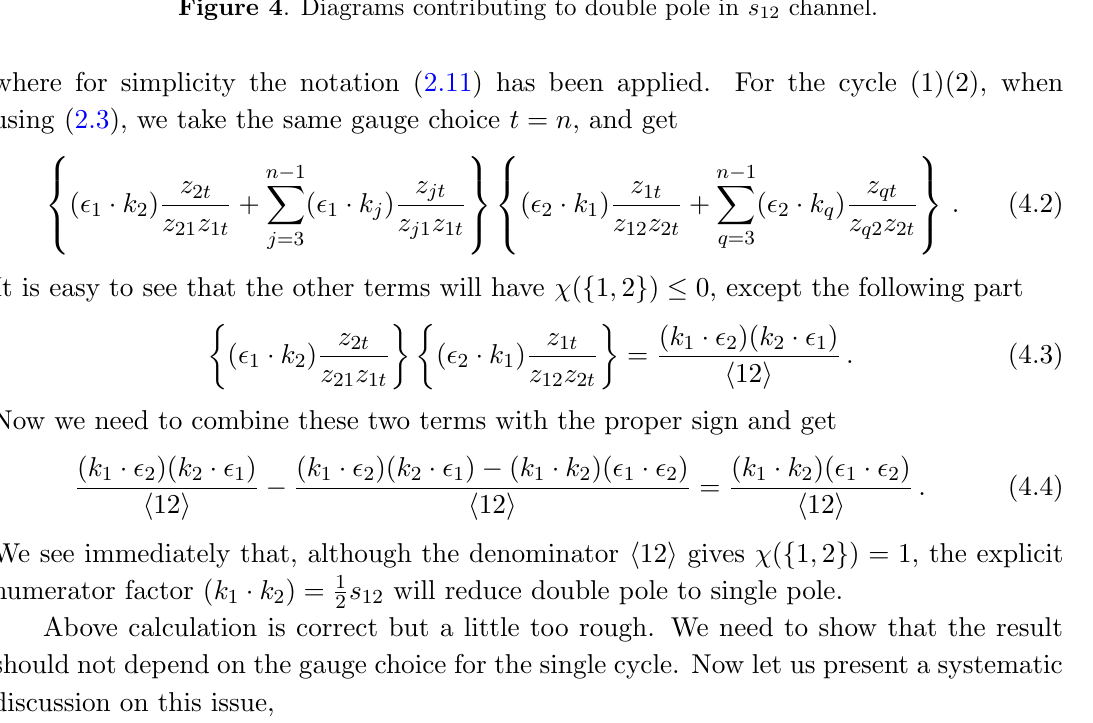
Figure 4 . Diagrams contributing to double pole in s 12